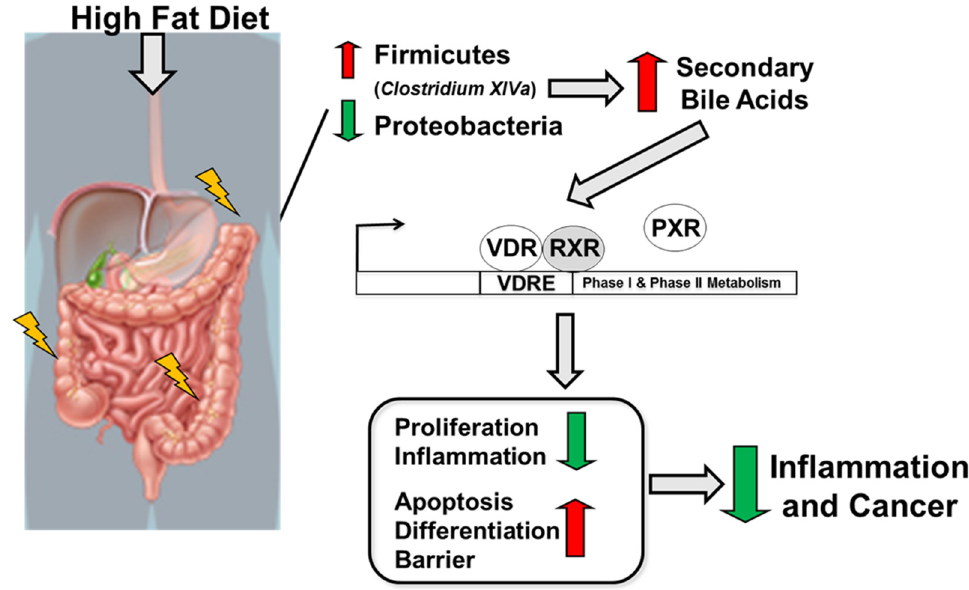
Figure 7. Schematic illustration of the impact of high-fat diet on the host, microbiota, and metabolites in regulating intestinal inflammation and cancer. in regulating intestinal inflammation and